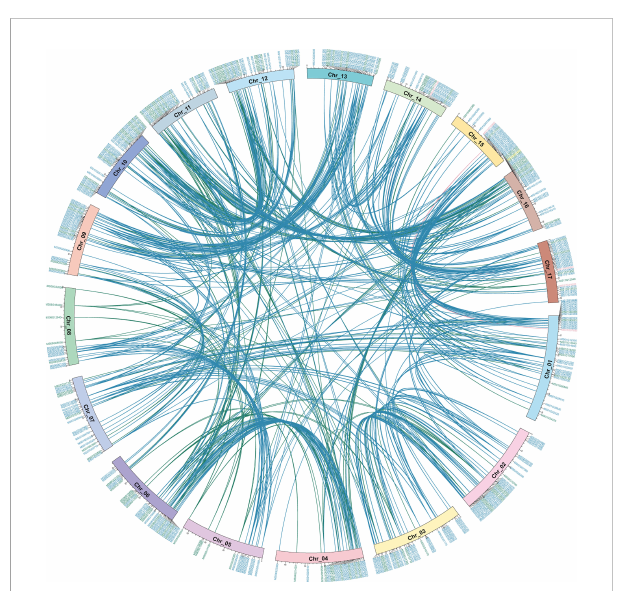
FIGURE 3 Self-Collinearity analysis and distribution of MsMYB genes in the Malus sieversii genome. Circle plot shows collinearity and distribution of the MYB gene family, and the colored lines highlightly link two syntenic MYB genes. Colored lines indicate collinearity relationship of 1R-MsMYB (blue), R2R3-MsMYB (green), and 3R- MsMYB (pink). Location of MYB genes on apple chromosomes (Chr_01~17). Colored IDs indicate 1R-MsMYB (blue), R2R3-MsMYB (green), 3R-MsMYB (pink), and 4R-MsMYB (yellow),